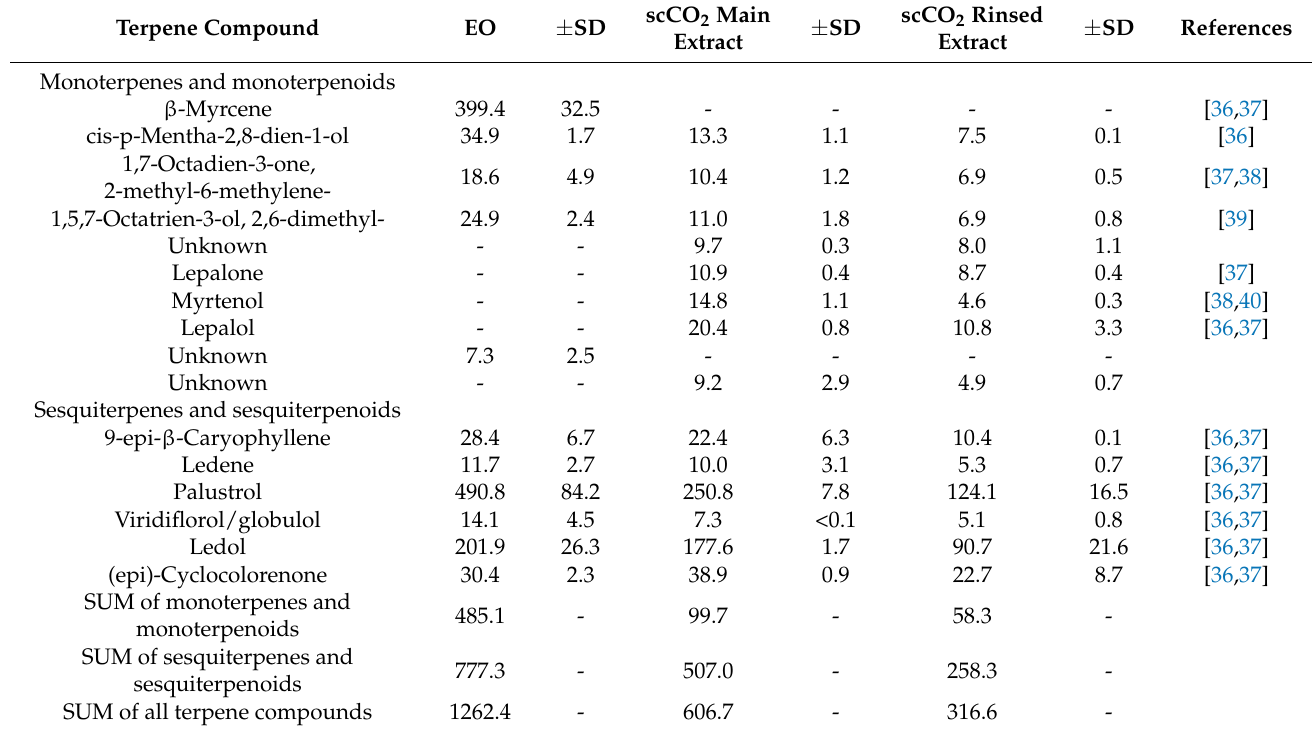
Table 5. Terpene content (mg/g) of air-dried common tansy inflorescence EO ( 3 ) and scCO 2 extract ( 6 ).